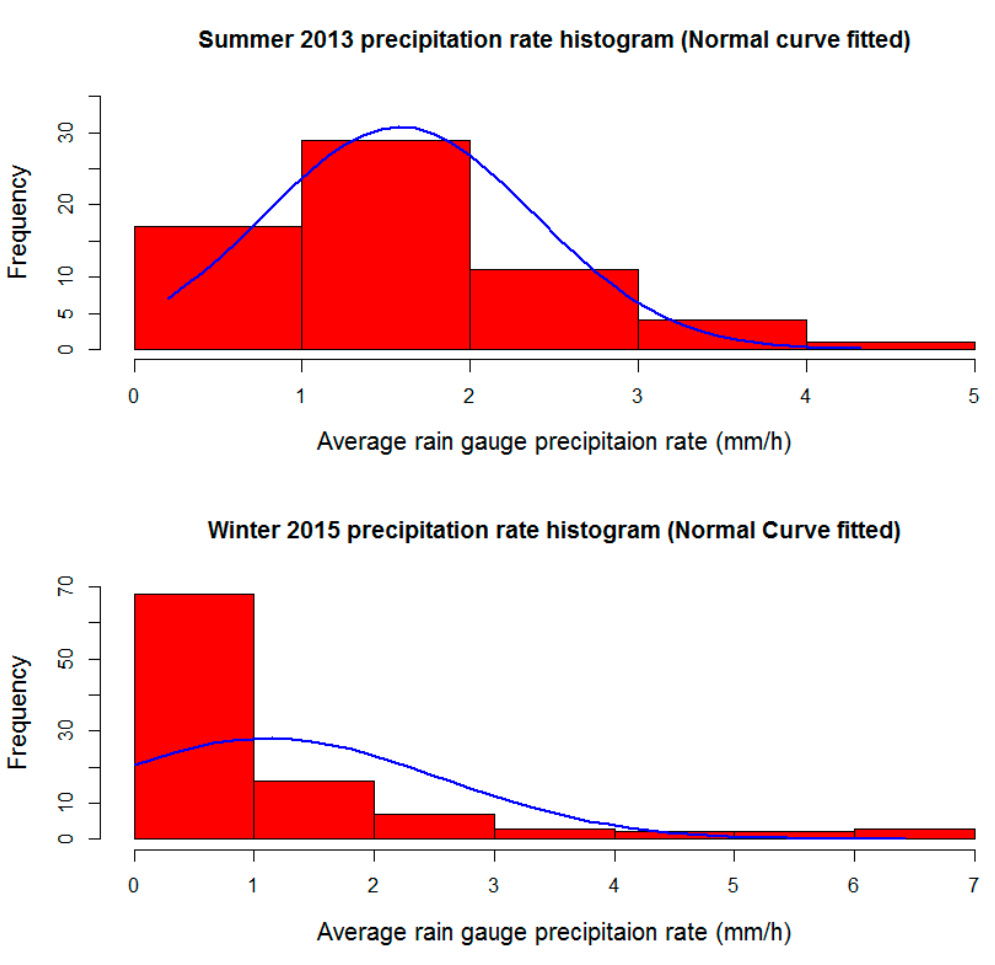
Figure 3. Precipitation rate histograms with a normal curve fitted for each season.